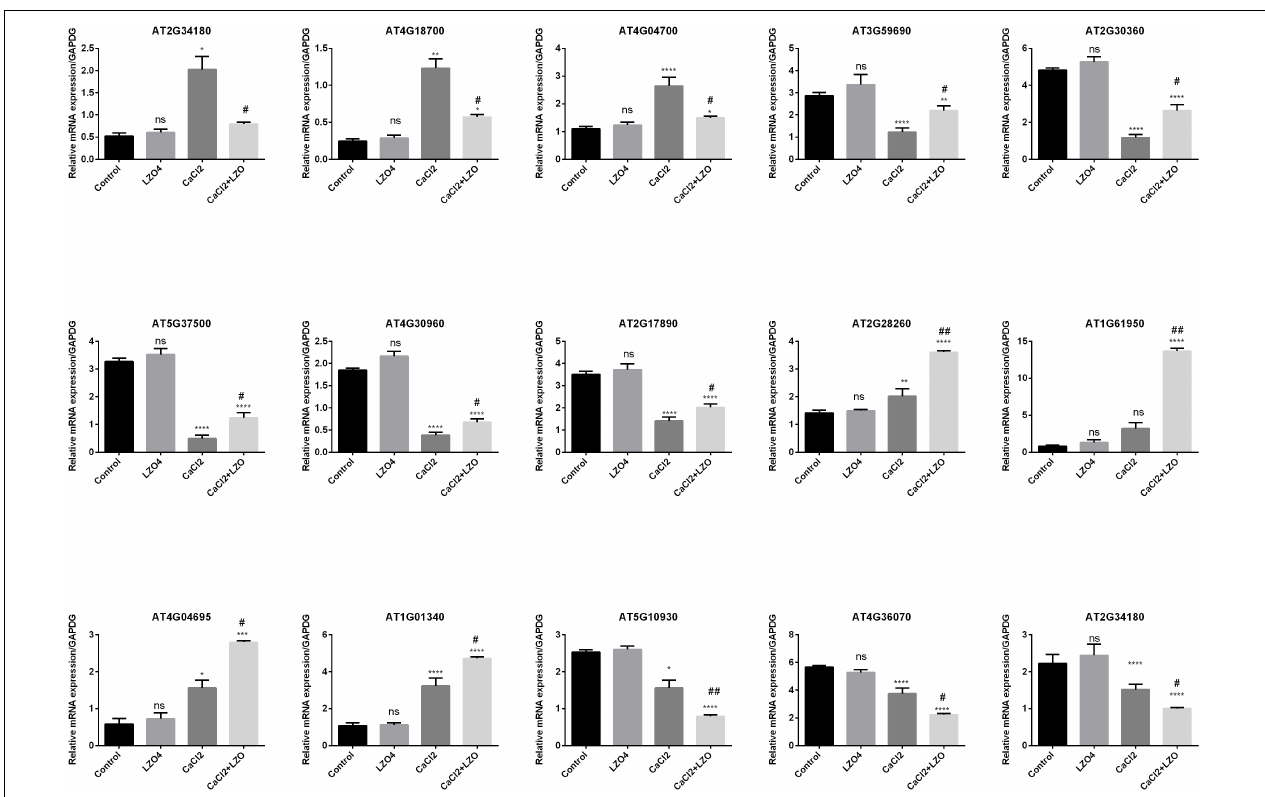
FIGURE 11 | RT-qPCR validation of the expression profiles differentially expressed genes in calcium-related gene families in the whole root of A. thaliana under calcium stress and treated with or without B. amyloliquefaciens . * p < 0.05, ** p < 0.01, *** p < 0.001, **** p < 0.0001 and ns = non-significant compared with control group. # p < 0.05, ## p < 0.01 compared with CaCl 2